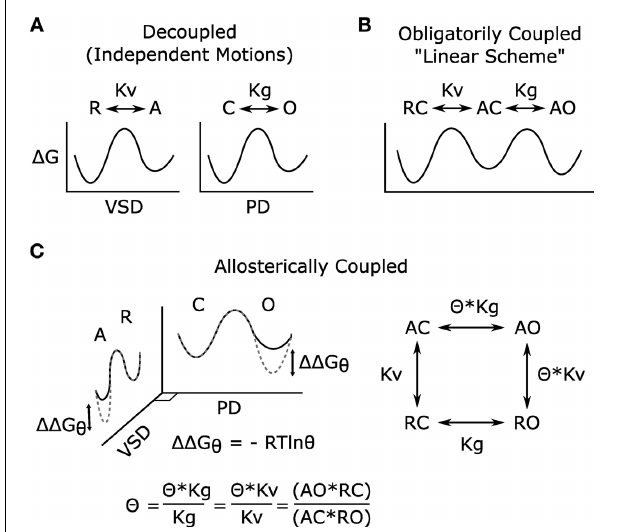
FIGURE 2 | Models of voltage-dependent gating. (A) The VSD and PGD are independent structural and functional domains; each domain on its own may undergo conformational transitions that can be described by independent energy landscapes. These hypothetical reaction coordinates illustrate the free energy associated with the different states of the domains and the transitions among them. In the voltage-gated ion channel, the conformational changes of these domains are coupled, and such coupling has been modeled in two different ways (B,C) . Here, for simplicity, all models are shown considering only one VSD, and both VSD activation and PGD opening are modeled as two-state processes, for full models see references (Zagotta et al., 1994; Horrigan and Aldrich, 1999). (B) Linear gating scheme in which VSD activation obligatorily precedes PGD opening, and coupling is not explicitly defined. (C) Allosteric gating scheme in which the distinctive nature of the two domains is represented, and the coupling is explicitly defined. In this simple model, the coupling factor ( θ ) has been normalized to represent the net coupling that is due to interactions among all states of the two domains and does not represent a single physical interaction (Chowdhury and Chanda, 2012). The effects of this coupling can be represented in the energy landscapes (C) where the difference between the dotted-gray and solid-black lines represent the free energy changes due to the VSD-PGD coupling. For example, within the PGD plane, solid-black and dotted-gray indicate the free energy landscape for PGD opening when the VSD is resting or activated, respectively. R, resting VSD; A, activated VSD; Kv, equilibrium constant for VSD activation; C, closed PGD; O, open PGD; Kg, equilibrium constant for PGD opening; (cid:2) , allosteric coupling factor; (cid:3) G, free energy of gating; (cid:3)(cid:3) G θ , free energy of coupling. As illustrated (C) , θ describes how much the open-close equilibrium is biased toward open when the VSD is activated. Equivalently, coupling can be quantified by measuring the effect of PGD opening on VSD activation, a measurement that is often more experimentally tractable (Arcisio-Miranda et al., 2010; Ryu and Yellen, 2012; Zaydman et al.,